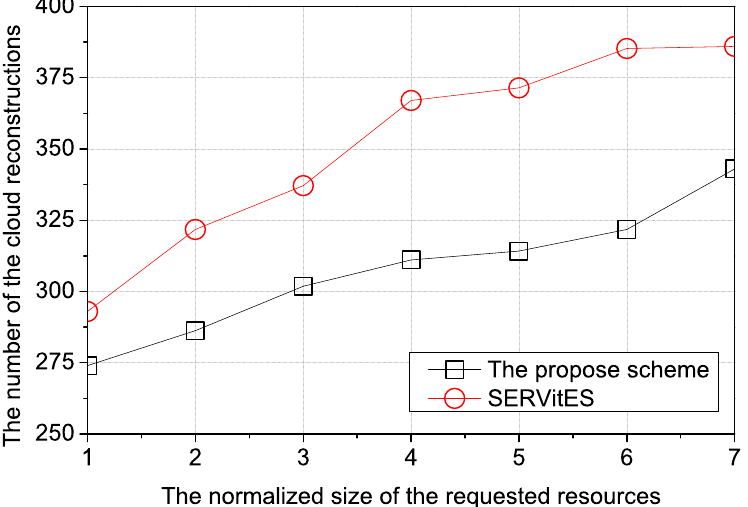
Figure 7. The number of cloud reconstructions according to the normalized size of the requested